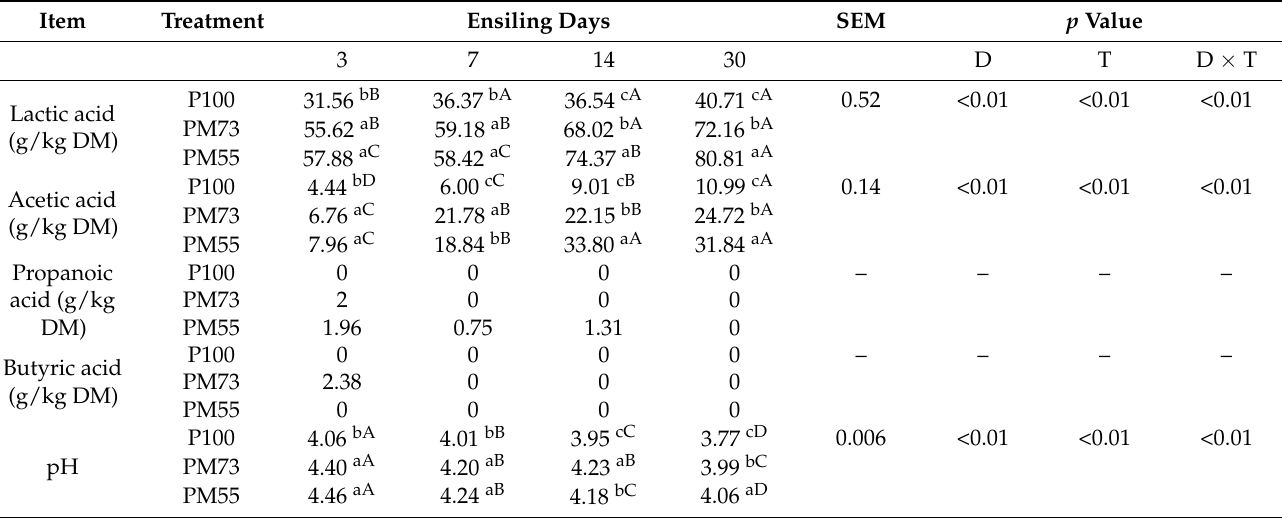
Table 4. Organic acid contents, pH of mulberry leaves and hybrid Pennisetum mixed